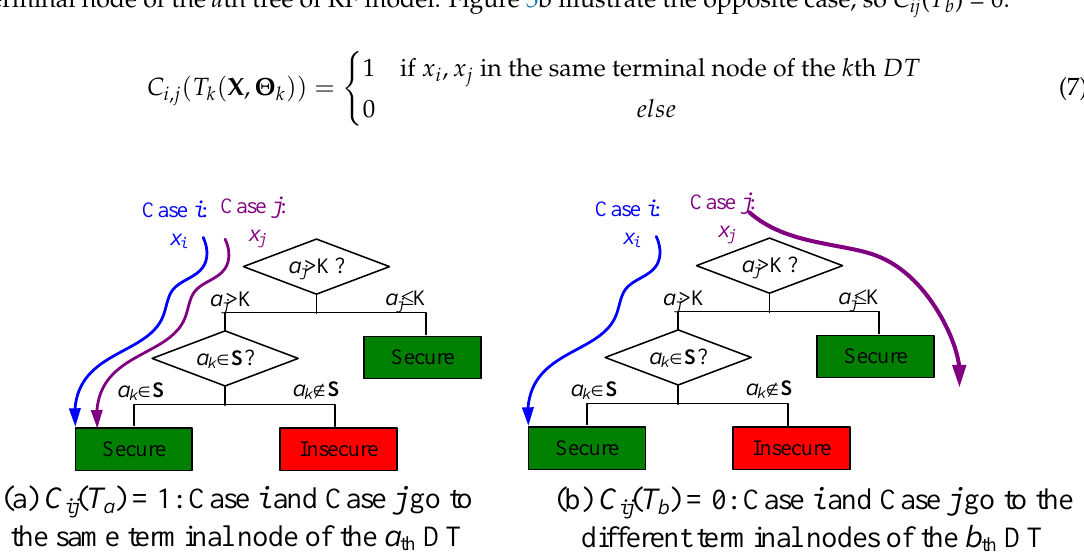
Figure 5. The illustration of one-zero function C ij that counts the number of DTs of which x i and x j go to the terminal node.